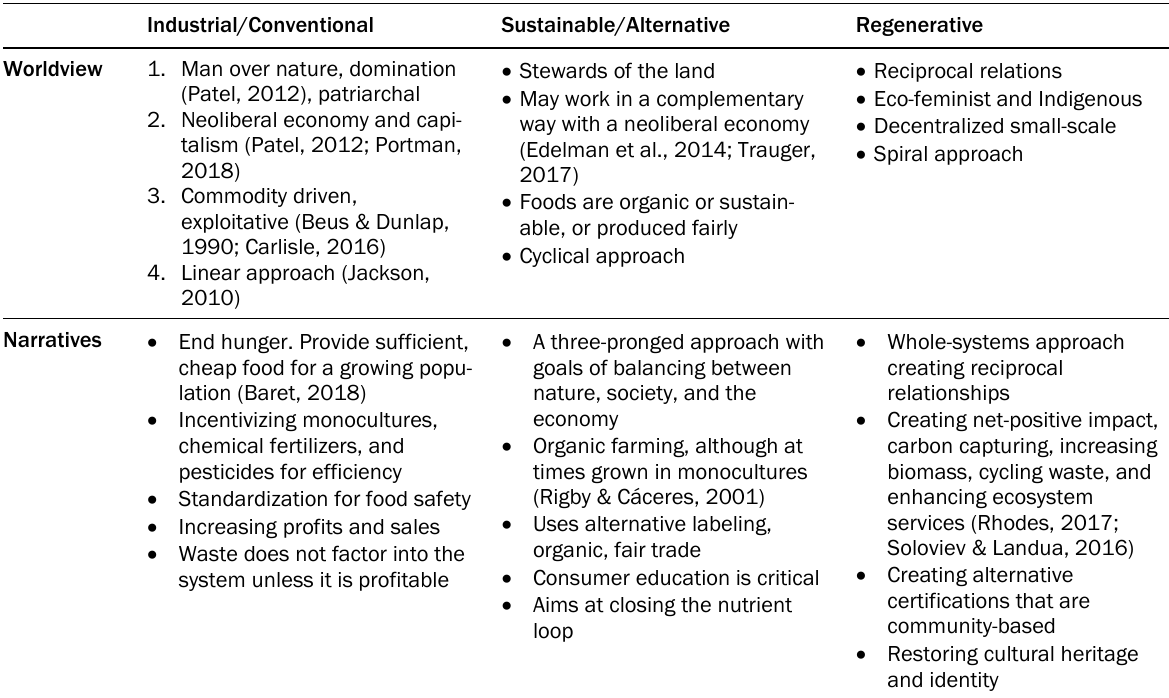
Table 1. Selected Industrial, Sustainable, and Regenerative Food System Worldviews and Narratives